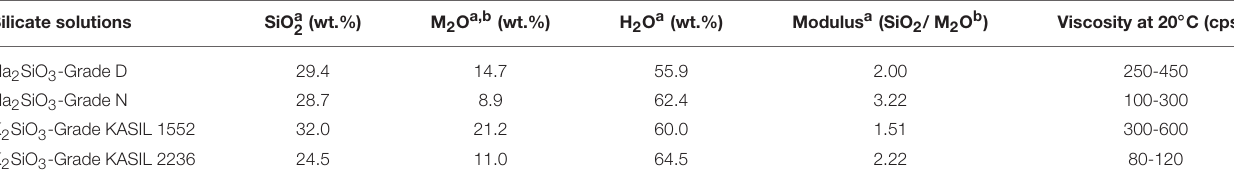
TABLE 1 | Specifications of the silicate solutions. Silicate solutions